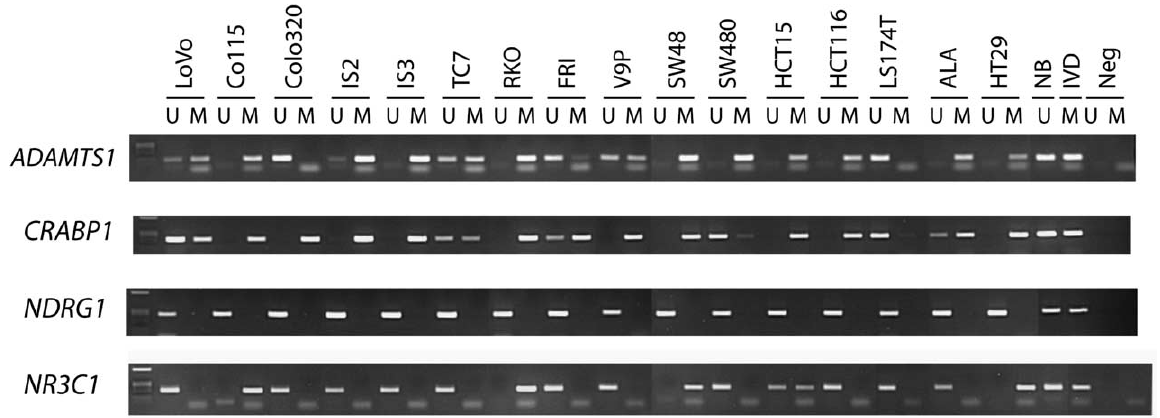
Fig. 2. Representative methylation-specific PCR results from the analysis of ADAMTS1 , CRABP1 , NDRG1 , and NR3C1 in sixteen colon cancer cell lines. A visible PCR product in lanes U indicates the presence of unmethylated alleles whereas a PCR product in lanes M indicates the presence of methylated alleles. NB, normal blood (positive control for unmethylated samples); IVD, in vitro methylated DNA (positive control for methylated samples); neg, negative control (containing water as template); U, lane for unmethylated MSP product; M, lane for methylated MSP product. Each gel panel is a merge of two to three gel panels mainly run on the same agarose